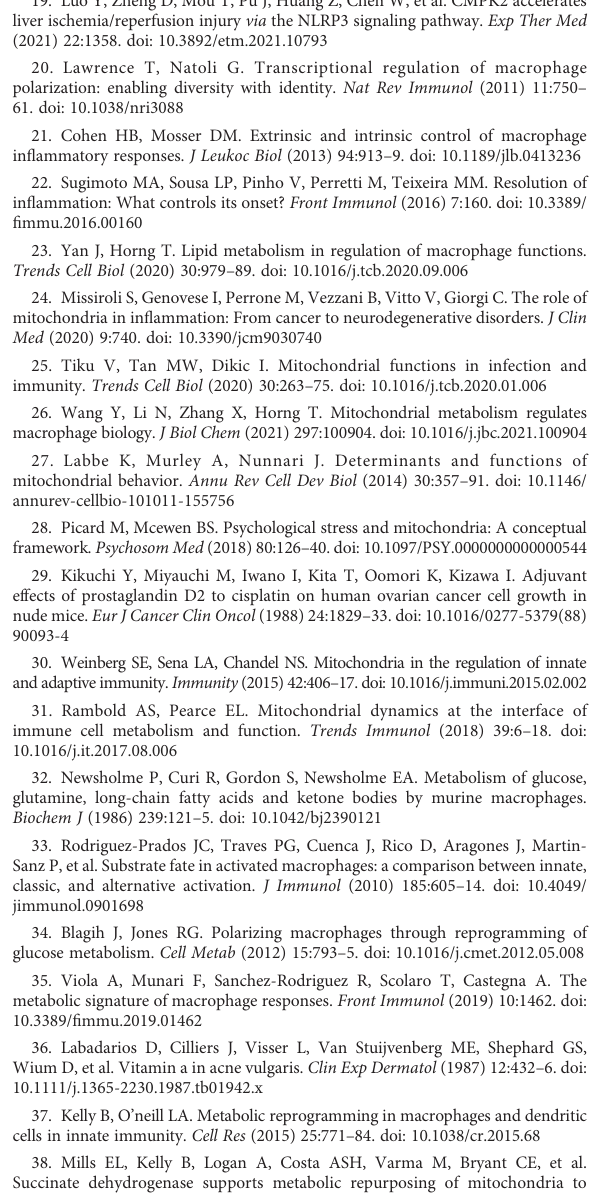
SUPPLEMENTARY FIGURE 5 Analysis of expression of protein complexes of the mitochondrial respiratory chain in cell lysates of NT and KD macrophages by immunoblotting. a -TUBULIN (T) and VDAC1 (VD) were used as loading controls. Thebandintensities ofthecomplex proteinswerenormalizedto a -TUBULIN and the relative intensity of KD w.r.t. NT is represented as fold change ± SEM for